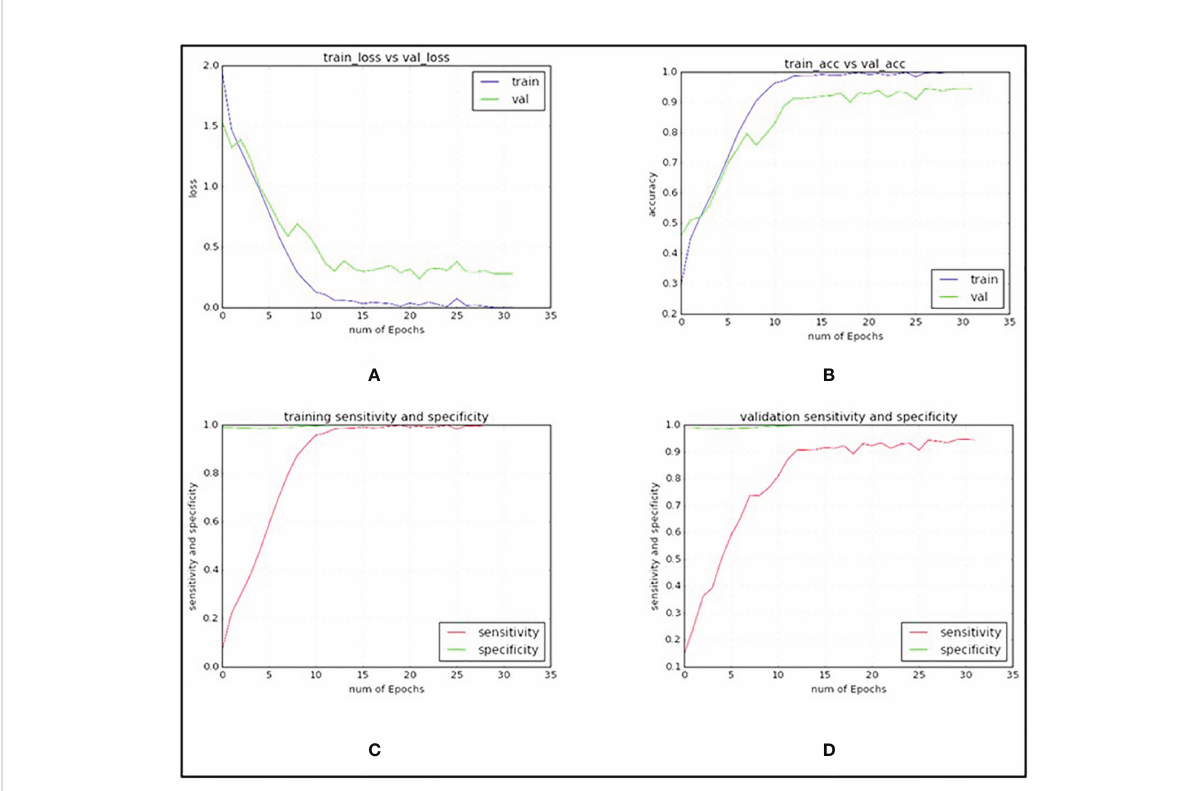
FIGURE 10 Graphs generated with PCA-5 bands on images with single fruit instances. (A) CNN training and validation loss graph. (B) CNN training and validation accuracy graph. (C) CNN sensitivity and speci fi city graphs on training dataset. (D) CNN sensitivity and speci fi city graphs on validation dataset.